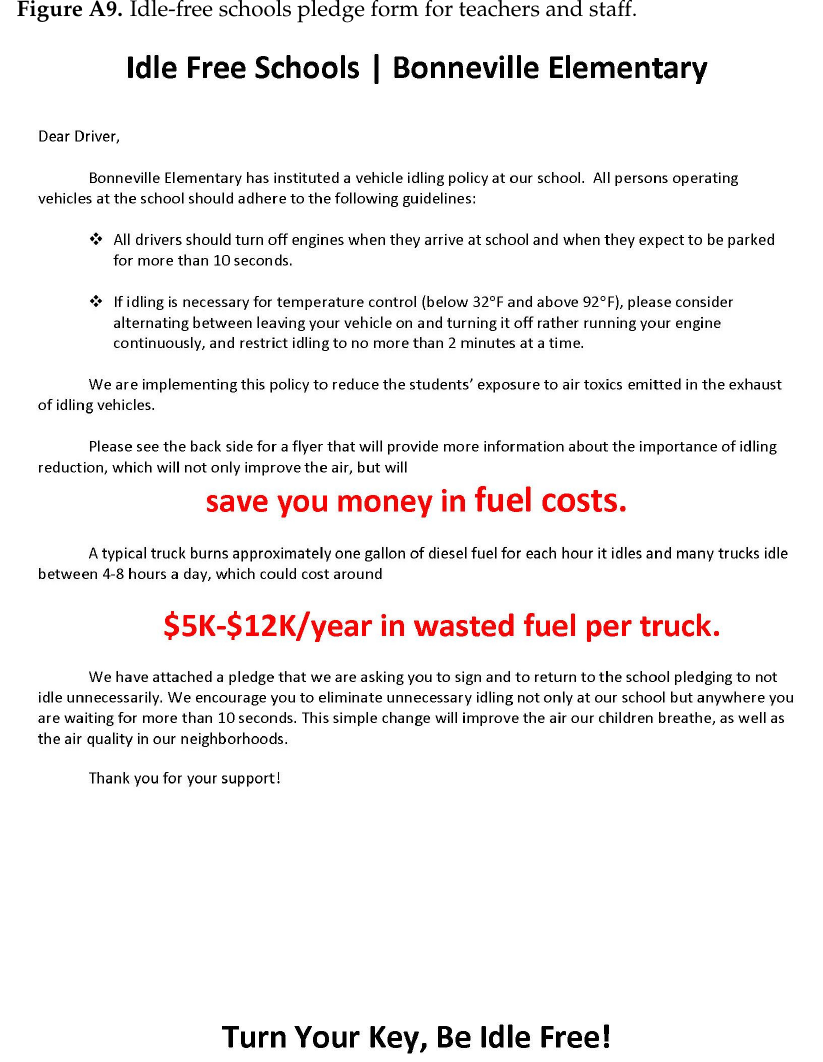
Figure A9. Idle-free schools pledge form for teachers and staff.